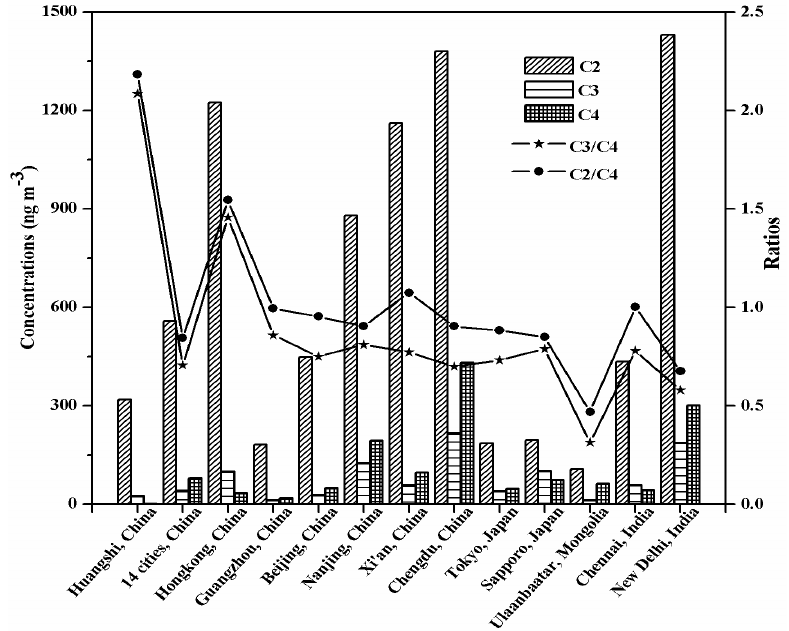
Figure 1. Comparison of the concentrations of oxalic (C 2 ), malonic (C 3 ), and succinic (C 4 ) diacids, and mass ratios of C 2 /C 4 and C 3 /C 4 in the PM 10 aerosols from Huangshi, Central China with the literature data for urban atmospheric aerosols. All of the ratios of C 2 /C 4 and C 3 /C 4 are plotted on a logarithmic scale.